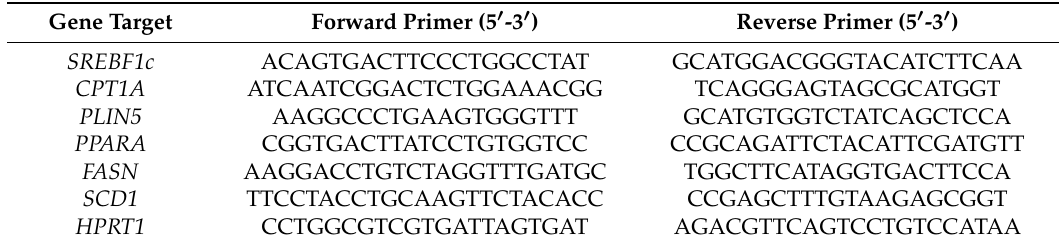
Table 2. Oligonucleotides used for quantitative RT-PCR analysis. Gene